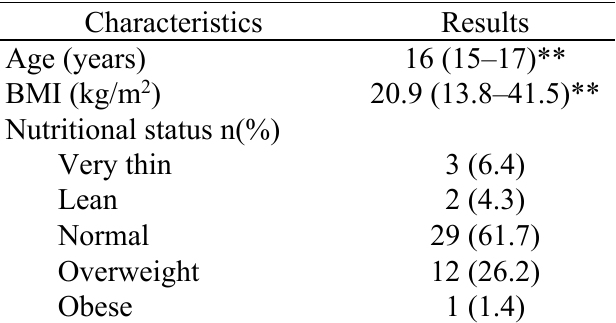
Table 1. Characteristics of subjects based on age, BMI, and nutritional status (n=47)